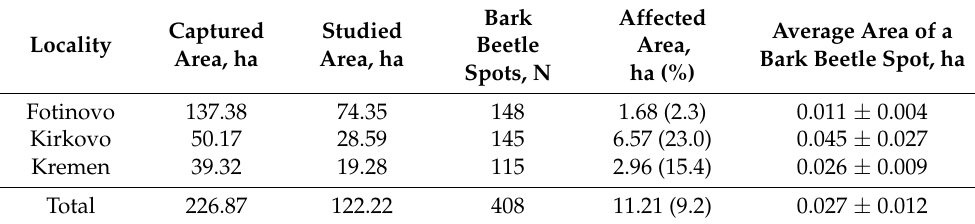
Table 2. Bark beetle spots in captured areas in 2019.